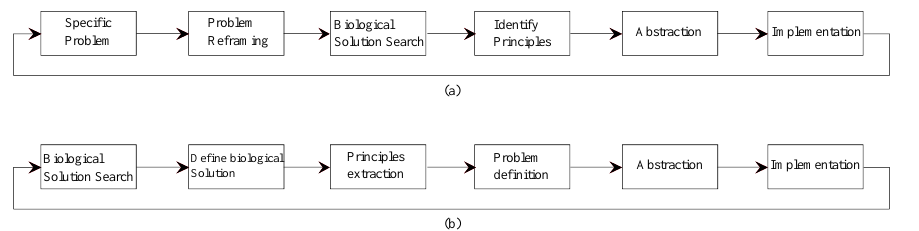
Figure 1. Sequences of biomimetic design process: progress of a biomimetic project from biological models to biomimetic applications: ( a ) Problem-oriented process; ( b ) Solution-oriented process.